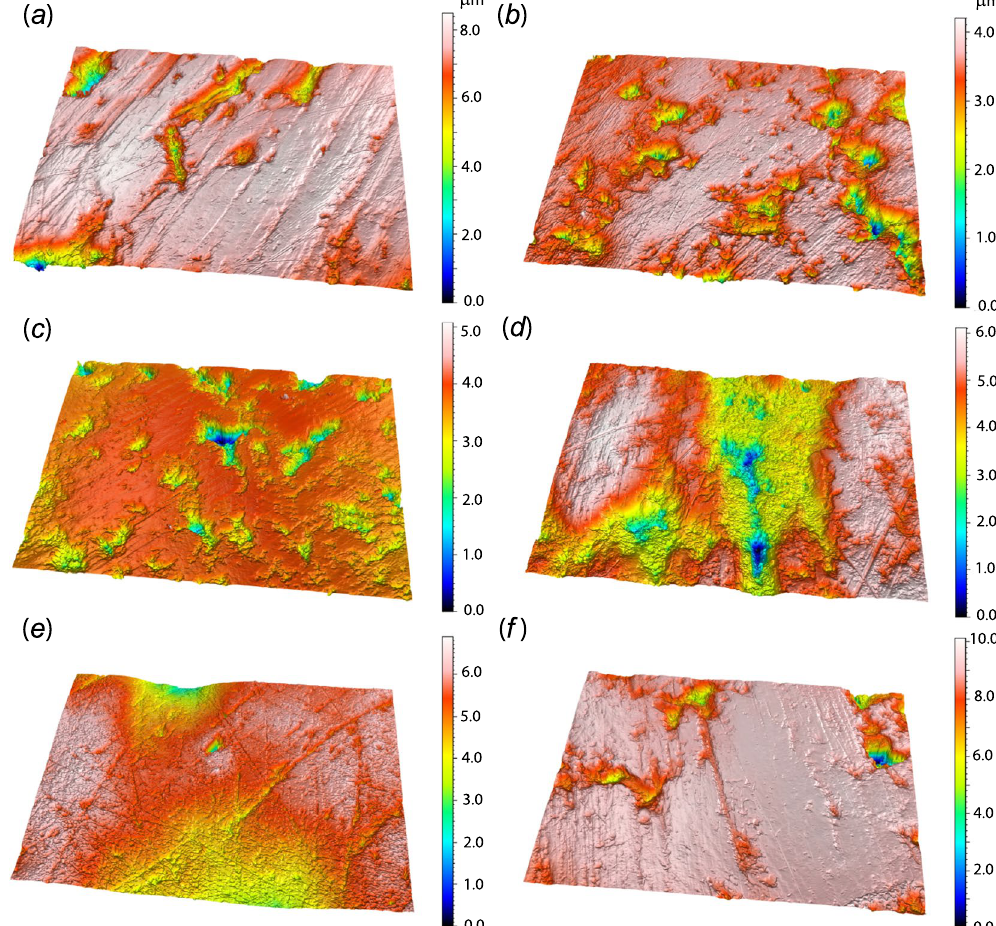
Figure 2. Digital elevation models of microwear surfaces of ( a , b ) wild-caught lions (FMNH 20762; FMNH 33479), ( c ) a captive lion (FMNH 54639), and ( d – f ) man-eating lions (Tsavo 1 st man-eater, FMNH 23970; Tsavo 2 nd man-eater, FMNH 23969; and Mfuwe man-eater, FMNH 163109). All models noted here represent 204 × 274 μ m in area with relevant z-scale bars noted for each image ( μ